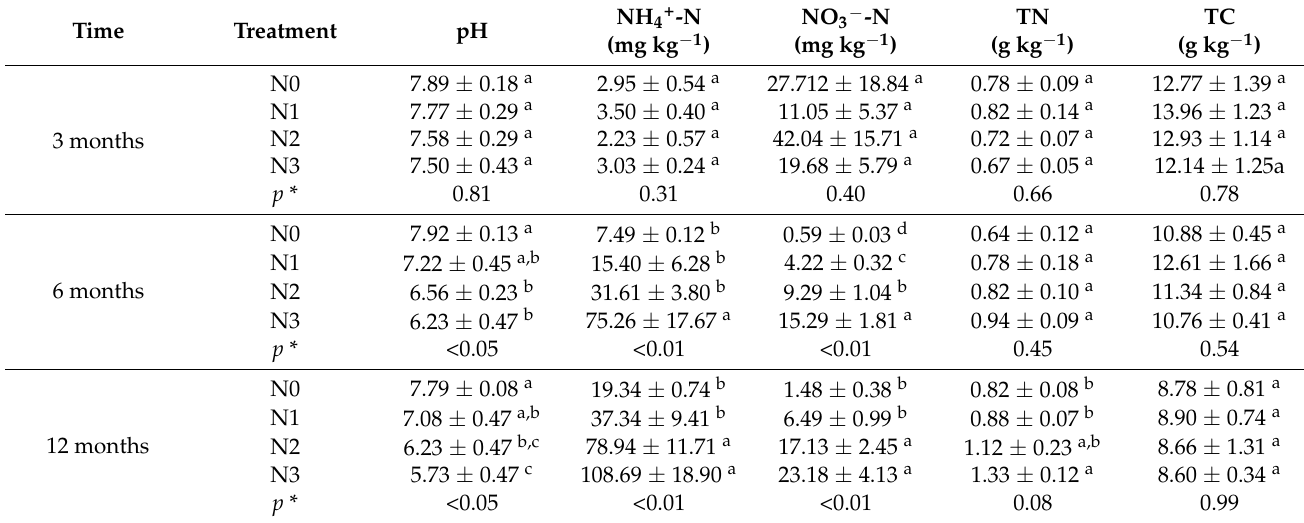
Table 1. Effects of N deposition on soil properties.